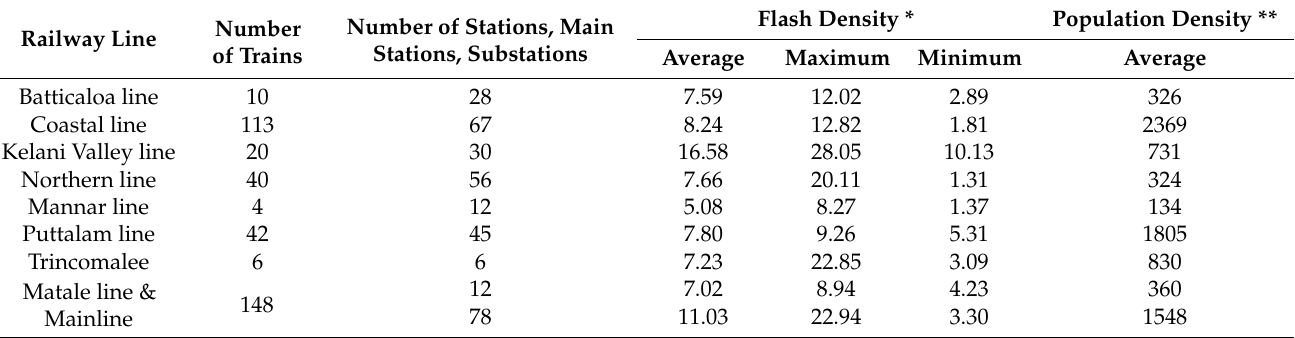
Table 6. Descriptive information on trains operated on weekdays, railway stations of the railway network, and descriptive statistics of flash density and population density over the railway network of Sri